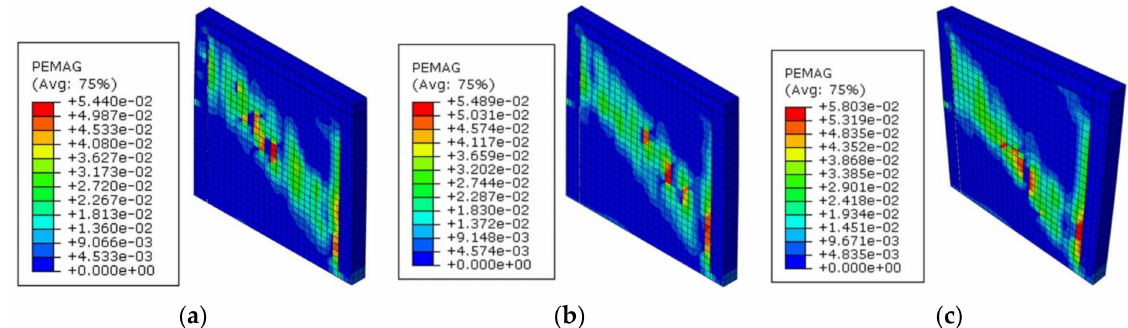
Figure 21. Plastic strain magnitude of the walls with different mortar strength: ( a ) wall ZWZ-2; ( b ) wall ZWZ-1; ( c ) wall